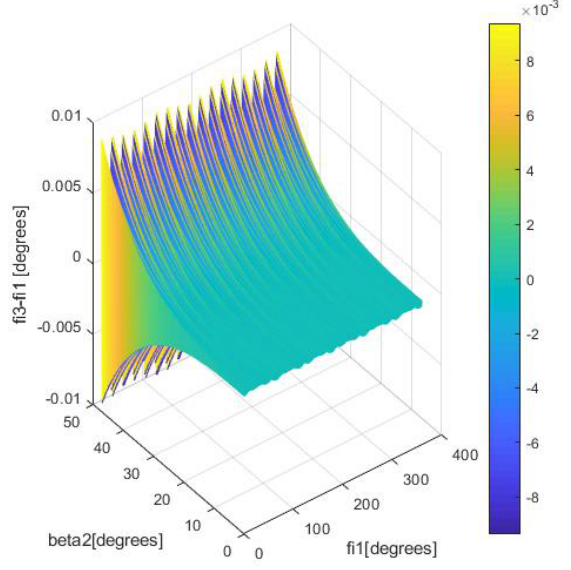
Figure 11. Geometrical nonuniformity of isometry for automotive driveshaft for r 1 /l = 0.11, r 2 /l = 0.09, β 2 = 47 ◦ .